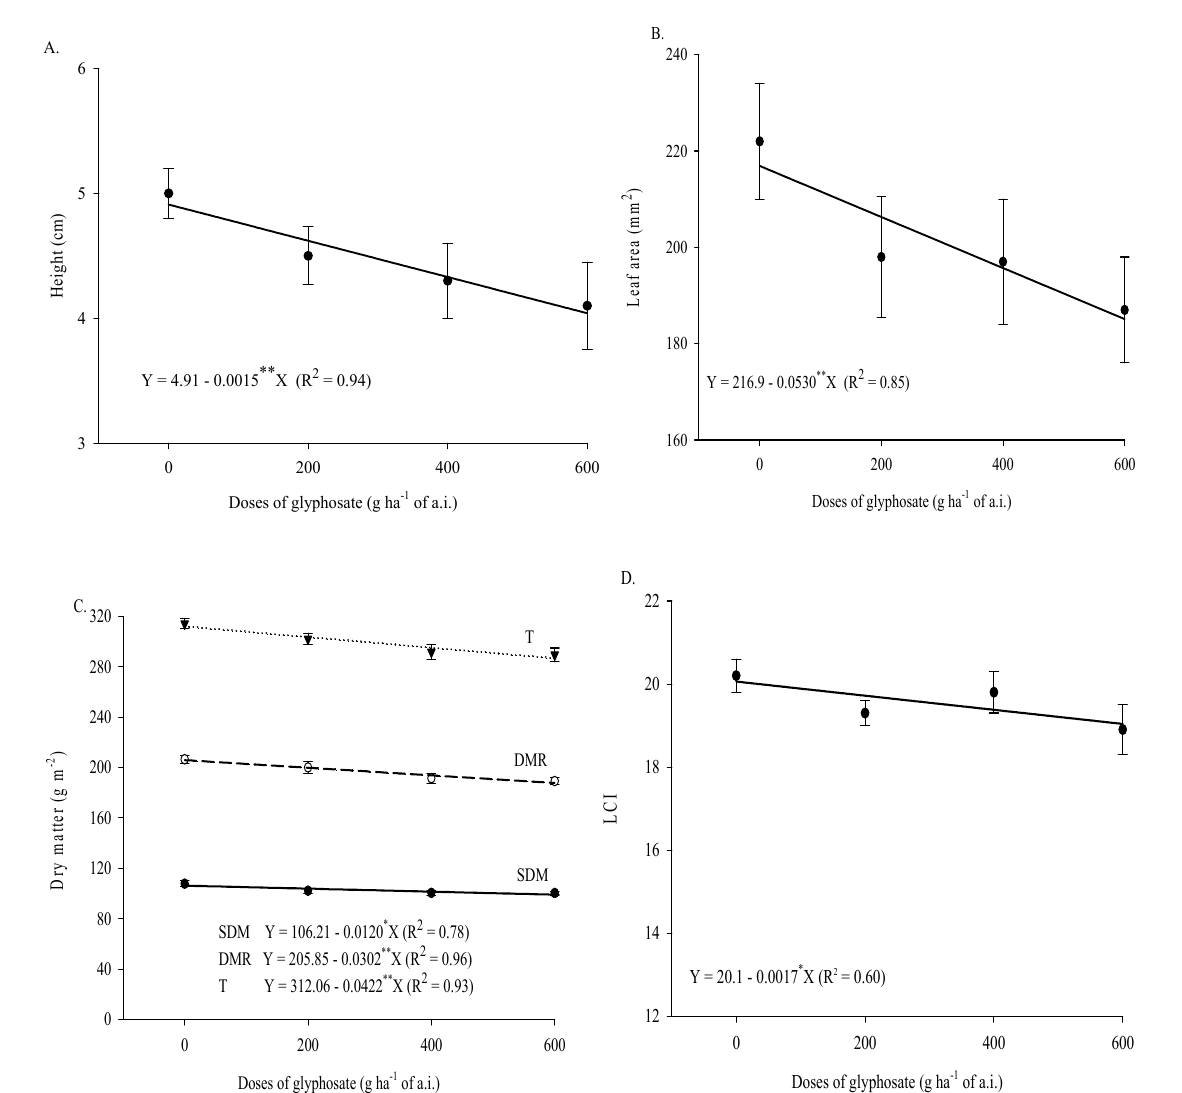
Figure 2. Height, leaf area, shoot dry matter (SDM), dry matter of roots and rhizomes (DMR) and total dry matter (T), along with the leaf chlorophyll index (LCI) of emerald grass as a function of doses of glyphosate ( A – D , respectively). The letters correspond to a significant difference at the 5% probability level ( p ≤ 0.05). ** and *: significant at p < 0.01 and 0.01 < p < 0.05, respectively. Error bars indicate the standard deviation of the mean ( n = 4).